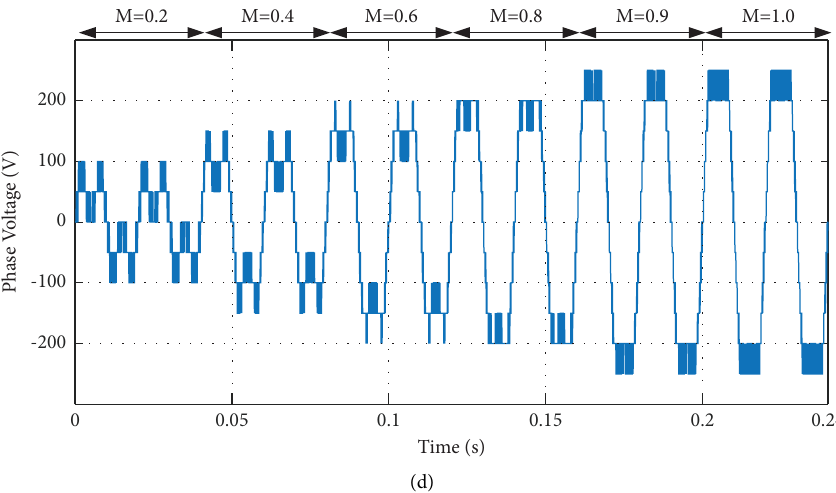
Figure 9: 11L CHB inverter phase output voltage for dynamic values of M. (a) SPWM. (b) THIPWM. (c) SVPWM-I. (d)